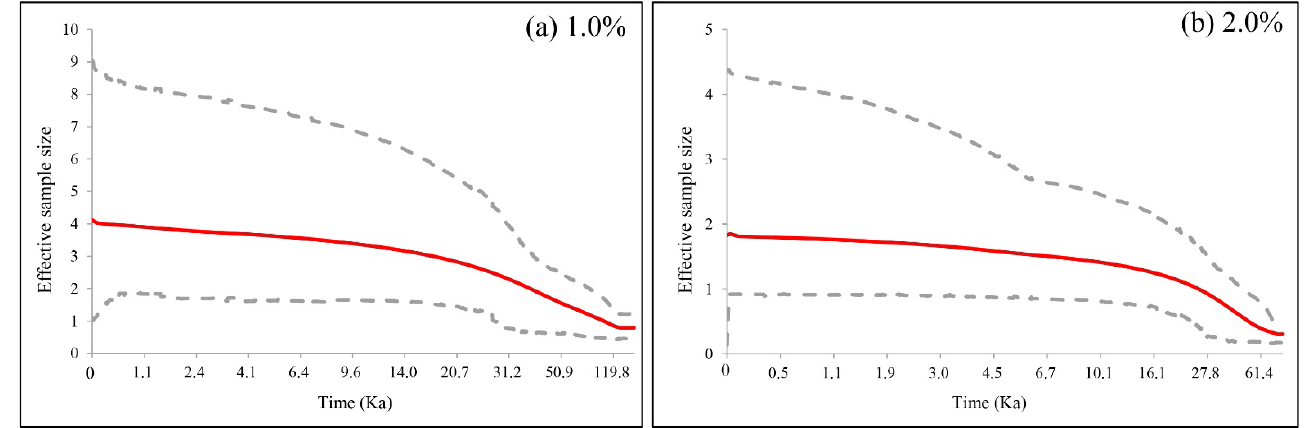
Figure 3. Extended Bayesian skyline plots of the Cytb gene using substitution rates of 1.0% ( a ) and 2.0% ( b ) per million years (Myr). The ordinate corresponds to Ne τ , the product of effective population size and generation length per millennium (ka), and the abscissa corresponds to time (ka). Estimates of means are joined by a red line, while the dashed lines delineate the 95% HPD limits. Using substitution rates of 0.756% and 1.513% per Myr for MCR, estimates of historical tween G1 and G2, between G1 and G3, and between G2 and G3. Additionally, asymmet-